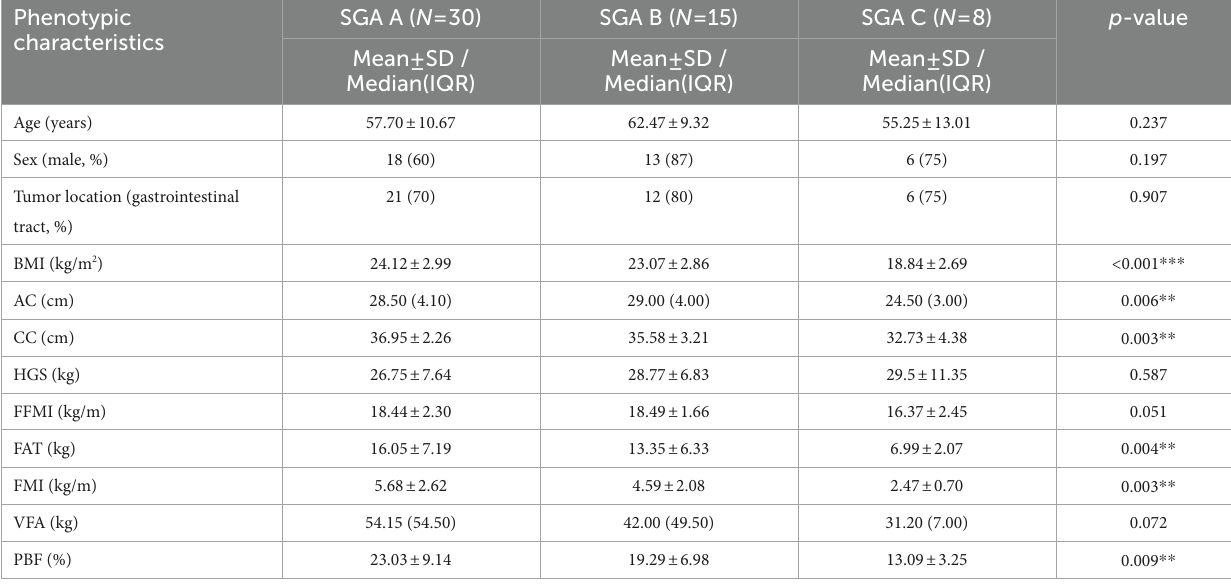
TABLE 1 Basic characteristics of malnutrition phenotypes in the study population. Phenotypic